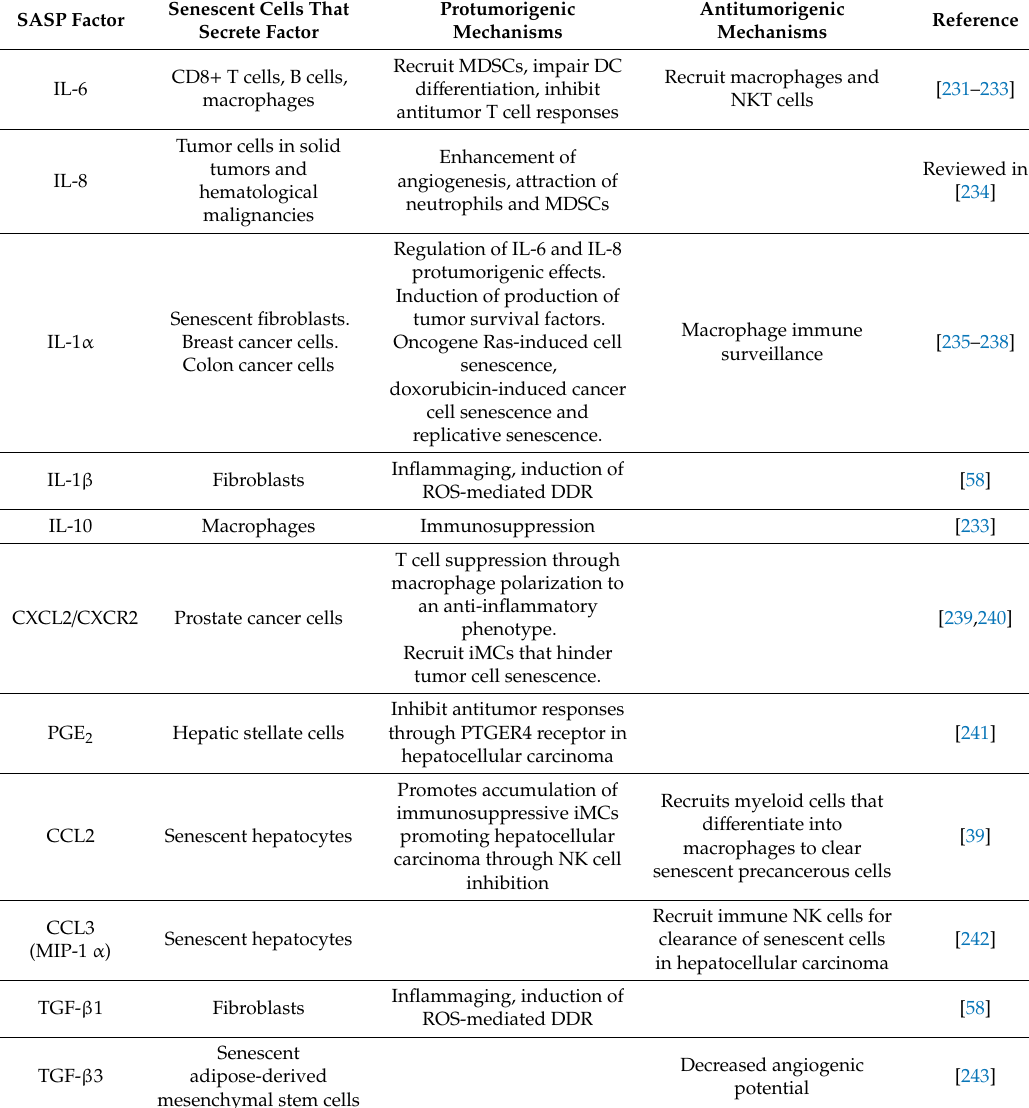
Table 2. SASP factors that influence immune cell function in